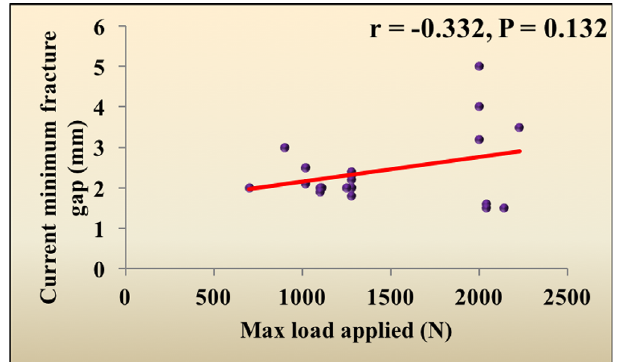
Figure 1. The correlation between the maximum load applied and the current minimum fracture gap.